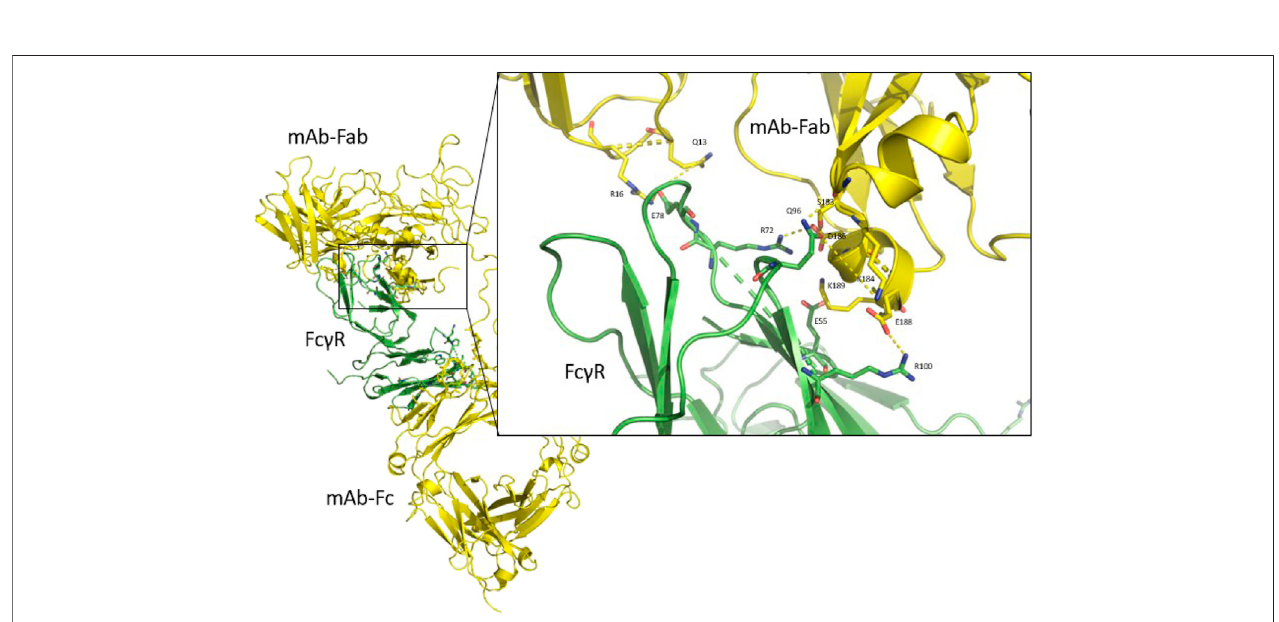
FIGURE7| Thecomplete antibody structure (yellow) interactingwith Fc γ R (green) withboth theFc region and theFab region. Close-up oftheinteractionbetween the Fab region, which interacts predominantly with its α -helix (residues 183 – 190), and the Fc γ R. Hydrogen bond interactions are shown as yellow dashed lines.